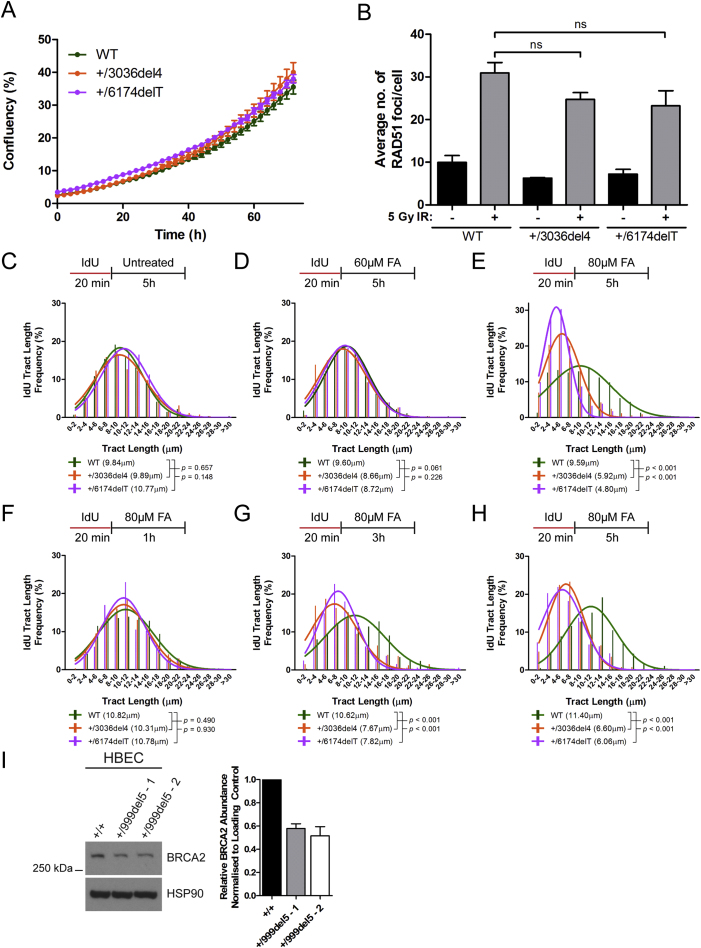
Related to Figure 2(A) Growth curves of HeLa Kyoto cells. Mean ± SD from nine fields of view.(B) Number of RAD51 foci per cell in HeLa Kyoto cells 3h after exposure to 5 Gy ionising radiation. Mean ± SEM, n = 3.(C–E) IdU tract length frequency distributions in HeLa Kyoto cells after treatment with different doses of FA for 5h.(F–H) IdU tract length frequency distributions in HeLa Kyoto cells after treatment with 80μM FA for different lengths of time.(I) BRCA2 protein levels in BRCA2+/+ or BRCA2+/999del5 human breast epithelial cells. Normalized BRCA2 band intensities are represented in the histogram. Mean ± SEM, n = 2.